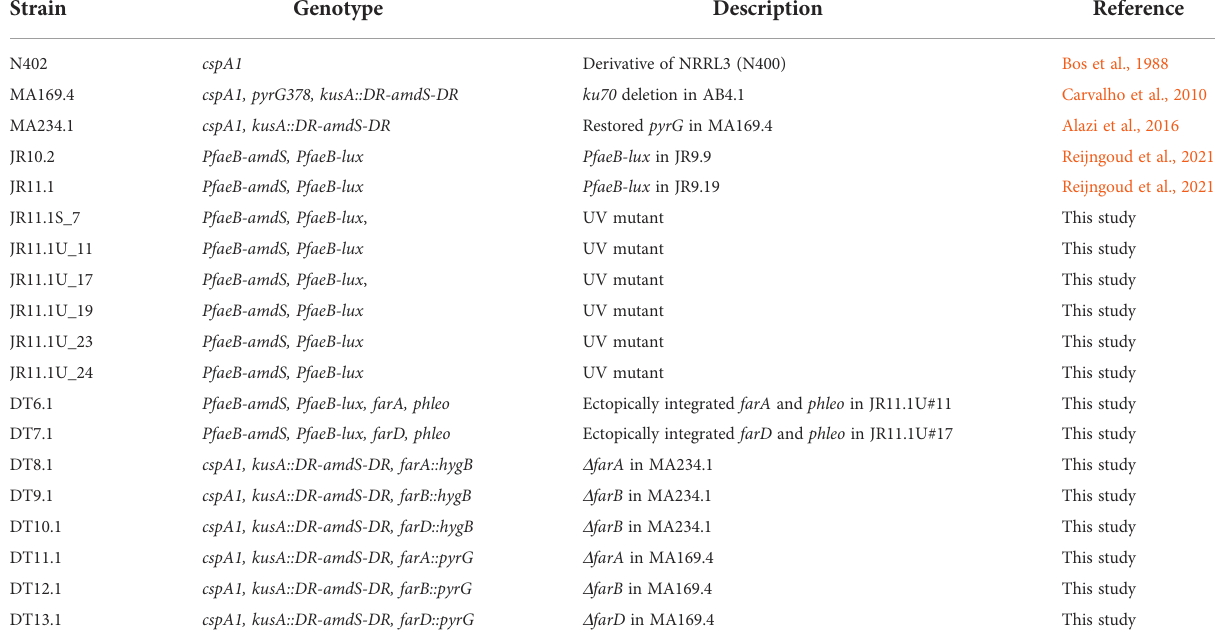
Supplementary Table 1. DNA fragments were puri fi ed